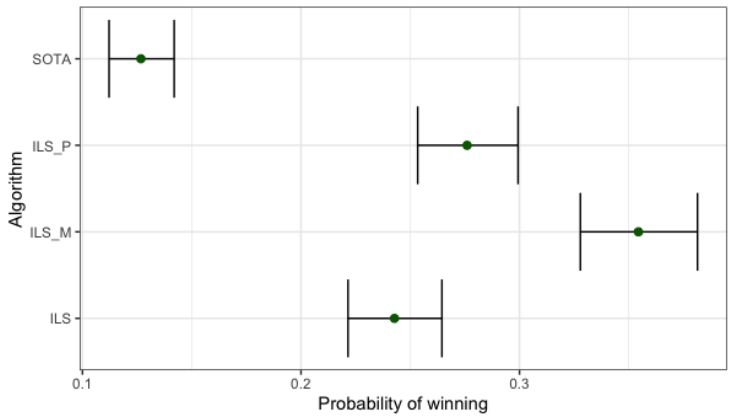
Figure 7. Credible intervals (5% and 95% quantiles) and expected probability of winning for the proposed Iterated Local Search (ILS) algorithms and the state of the art